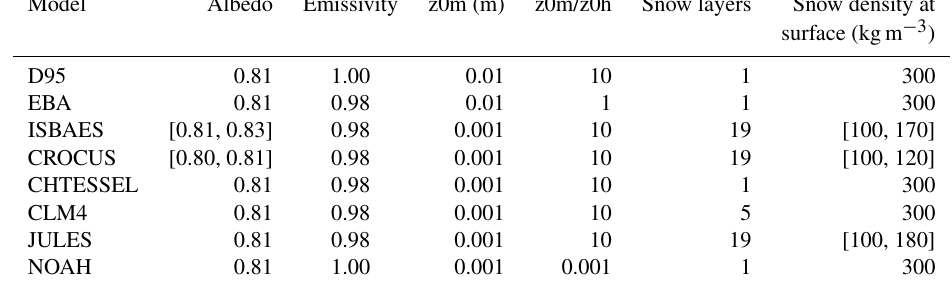
Table 5. Range of variation of model surface parameters for XP1. The values in square brackets indicate the values taken by a parameter when it is calculated by the model, while the single values are fixed during the simulation.